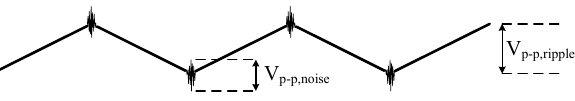
Figure 1. Output voltage ripple (V p-p,ripple ) and switching noise (V p-p,noise ).